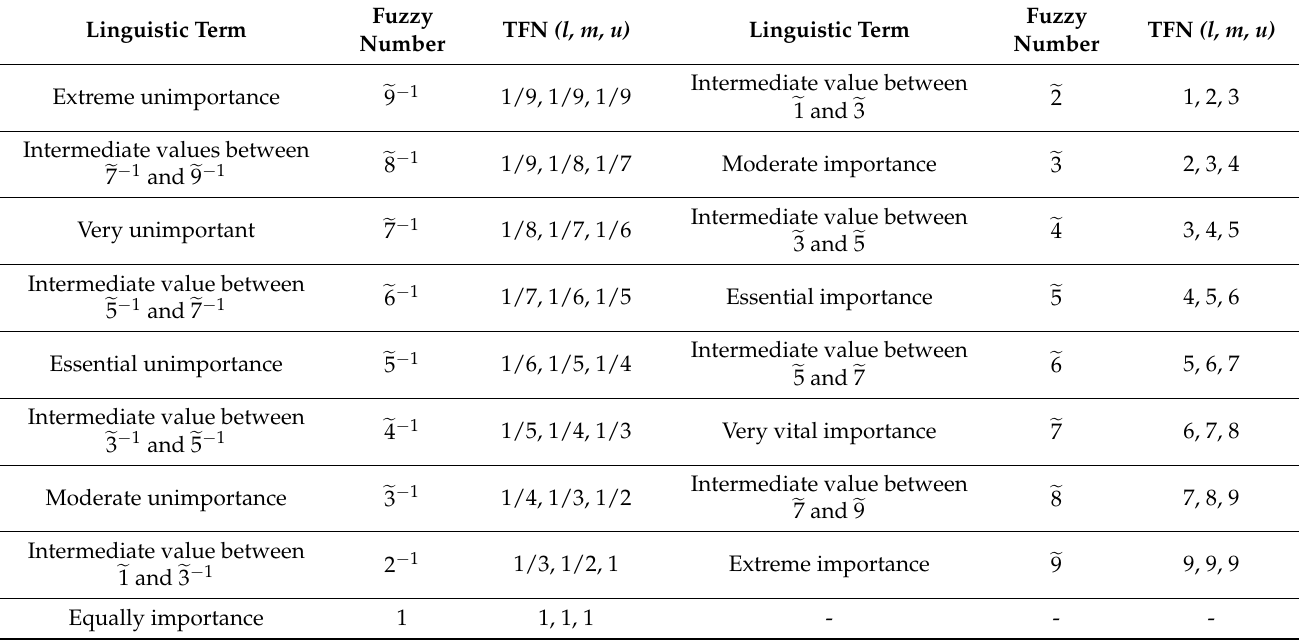
Table 3. Fuzzy scales and triangular fuzzy numbers (TFN) used for linguistic